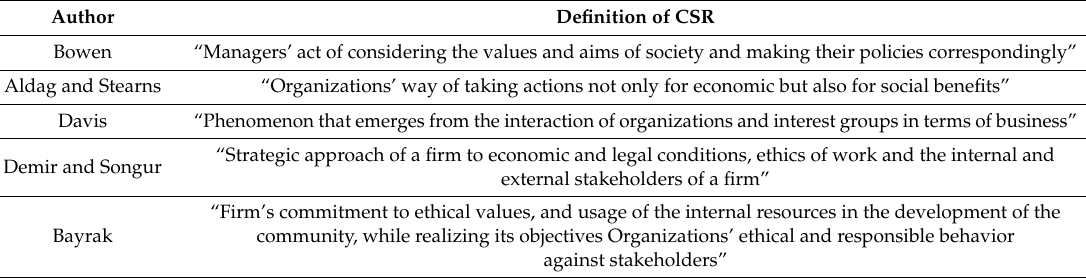
Table 1. The definitions of Corporate Social Responsibility